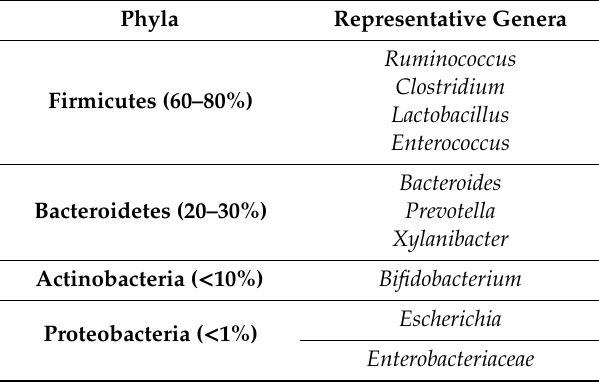
Table 1. Major bacteria phyla and genera predominating in human gut